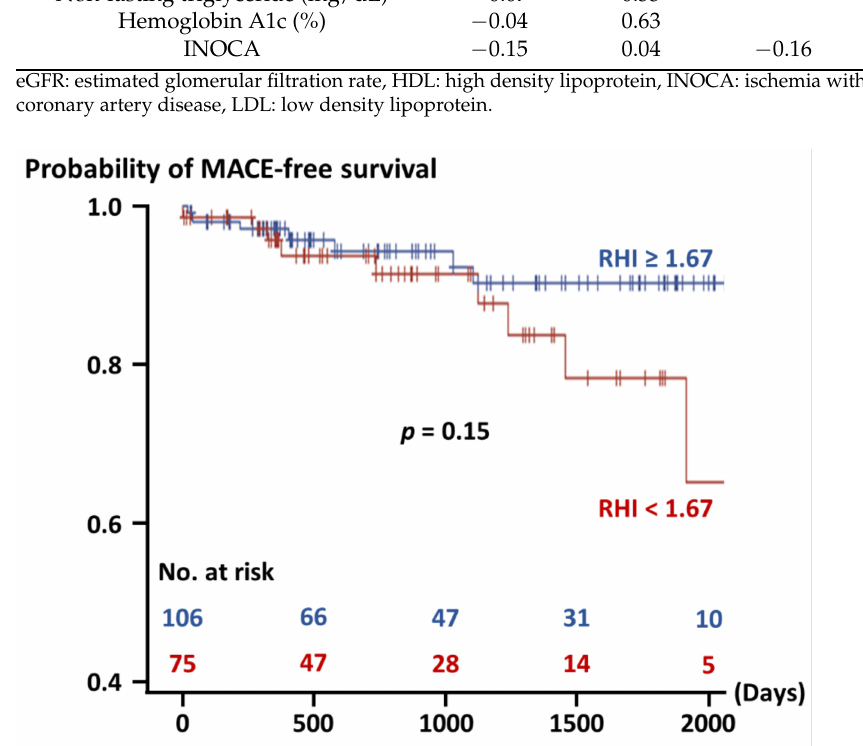
Figure 2. Probability free from major adverse cardiovascular events. MACE: major adverse cardio- vascular events, RHI: reactive hyperemia